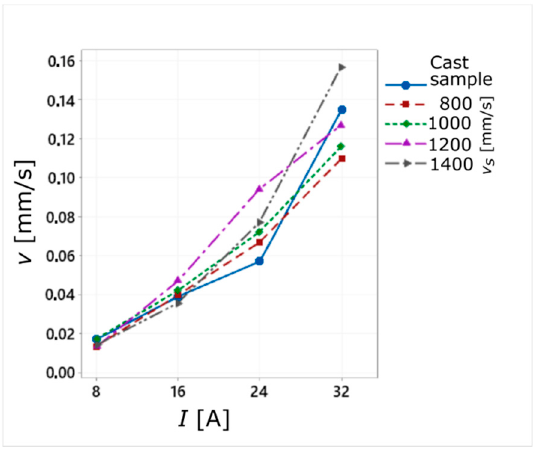
Figure 4. Relationship between input parameters ( I , v s ) and the average values of the cutting speed